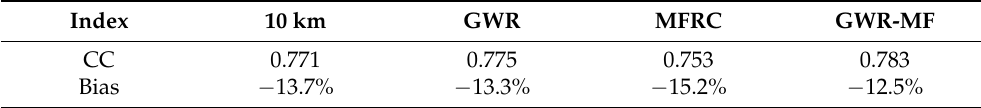
Figure 12. Initial 10 km precipitation grid ( a ) and the different downscaled results of the GWR model ( b ), MFRC model ( c ), and GWR-MF model ( d ) in July 2016. Table 2. CC and bias values of four precipitation grids in July